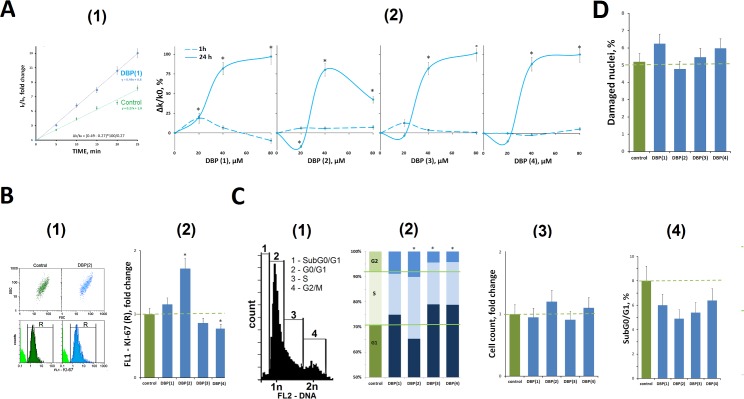
A (FL-reader).(1)–Example of reaction rate constant determination for DCF formation when DCFH reacts with ROS. Cells were cultivated for 24 hours in the presence of 40 μM DBP(1). The cultivation environment was replaced by 5 μm H2DCFH-DA in PBS solution and a relative fluorescence intensity increase was detected. It,I0 –sample’s signal at time t and immediately after H2DCFH-DA addition respectively. The slope of the line– reaction rate constant for DCF formation (k). ROS index Δk/k0 = (kDBP−k0)×100/k0 (%). (2)—Relationship between ROS index Δk/k0 and DBP(1–4) concentration. Time of cultivation is shown on the figure. B (FCA). Proliferation of MCF-7 cells exposed to DBP(1–4) at final concentration 20 μM for 24 hours. (1)—Distribution of fluorescence of fixed cells stained with anti-Ki-67 antibodies (control—dark green color, DBP(2) as example—blue color). Background fluorescence was quantified using FITC-conjugated secondary antibodies (green color). (2)—The median signal intensity of FL1 (Ki-67+) (gate R). Each experiment was repeated at least three times. Results represent the average of the medians of the FL parameter in independent experiments. C (FCA). (1)—Distribution of fluorescence of fixed cells stained with propidium iodide. The fractions of (1–4) cells with different DNA amounts are shown. (2)–Proportion MCF-7 culture cells with DNA amount corresponding to the G1-, S—and G2/M phases of the cell cycle. The data shown is an average value from three independent experiments. (3) The total number of cells in culture. (4) The number hypodiploid cells (fraction SubG0/G1).D. The proportion of cells in culture with signs of apoptotic nuclei (condensed chromatin, the irregular nucleus shape, see Fig 4). B, C, D–cells were cultivated in the presence of 20 μM DBP(1–4) for 24 hours.